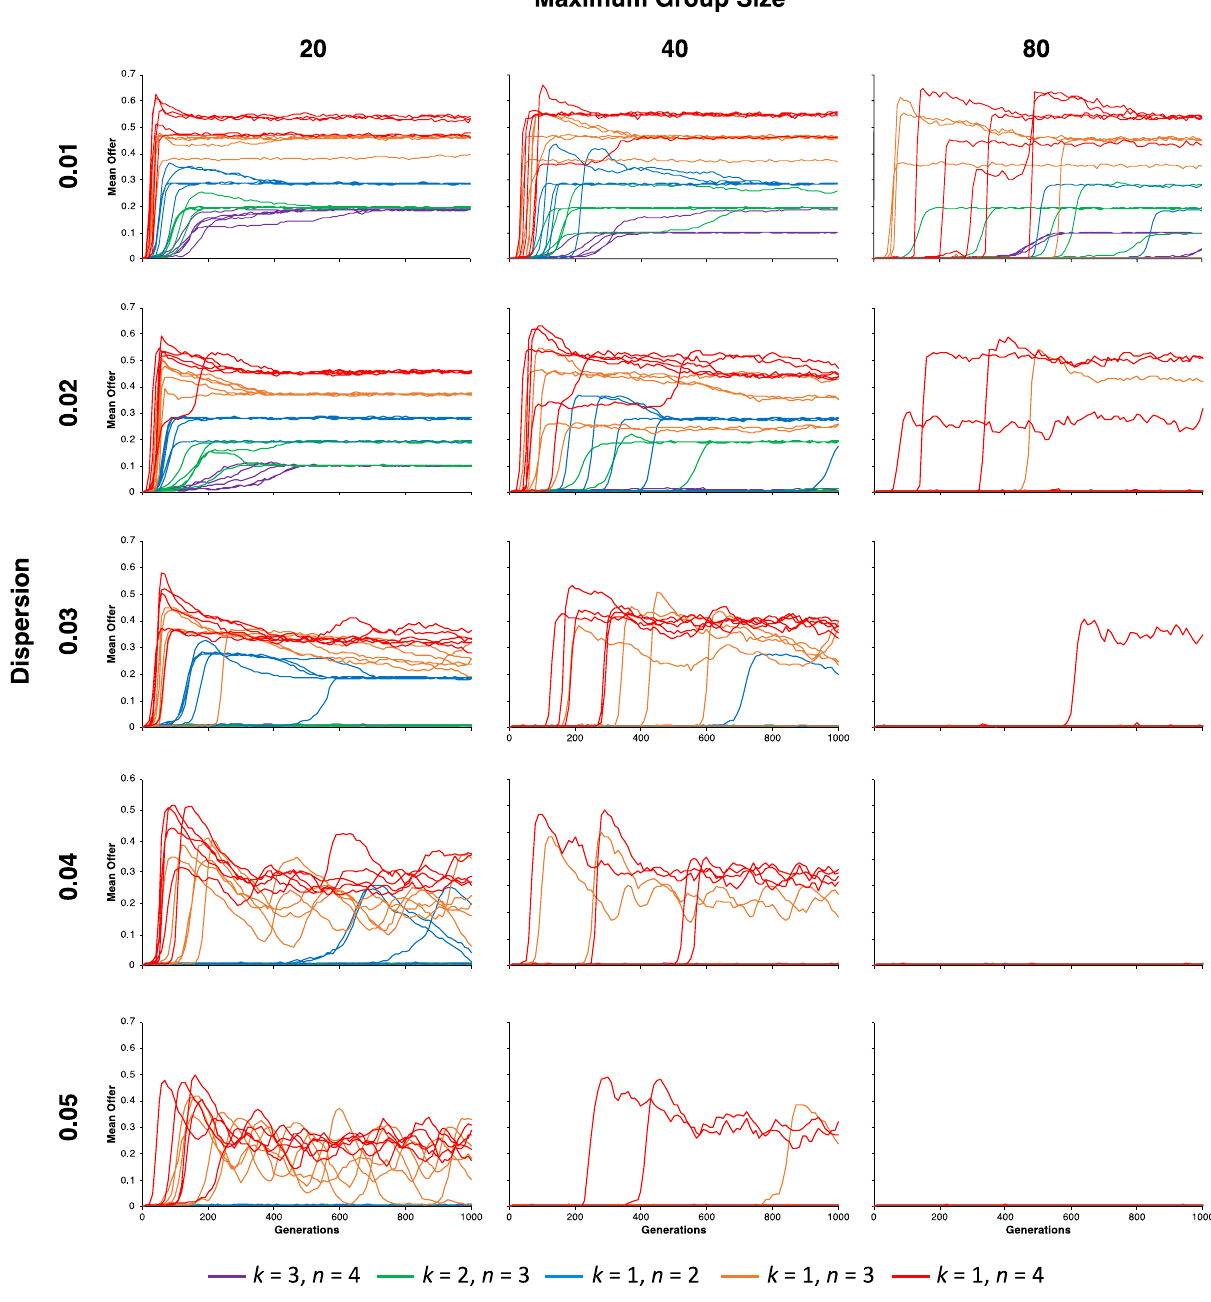
Figure 5. Invasion analysis of equitable offer strategies in group-structured and unstructured populations for τ 0 = 270, γ = 0.9, and c = 0.01, where group size and offspring dispersal rates were systematically varied. As group size and offspring dispersal rates increased, the evolution of equitable offers decreased. The selection for equitable offers decreases most rapidly for multi-dictator games and least rapidly for multi-recipient